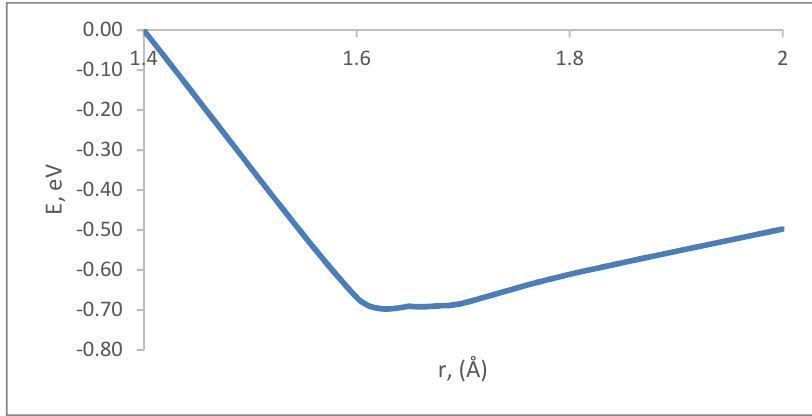
Figure 1. The CNT model with a surface functionalized by an amino group.